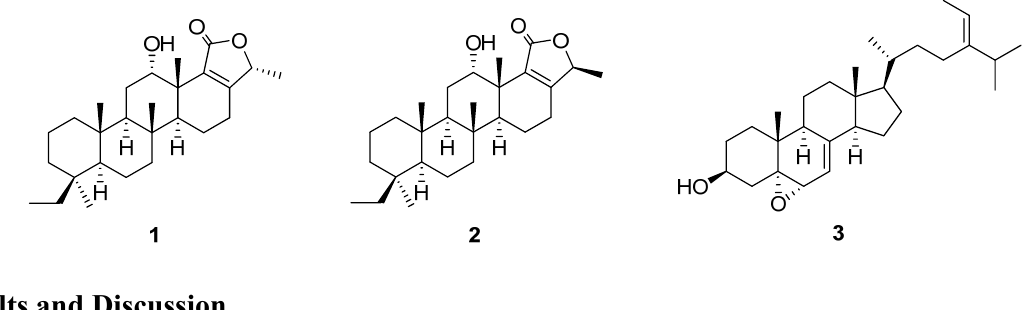
Figure 1. Structures of compounds 1 − 3